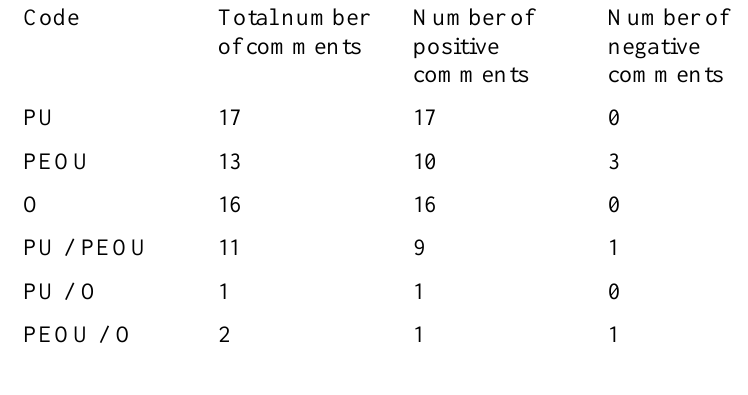
Coding of Comments from